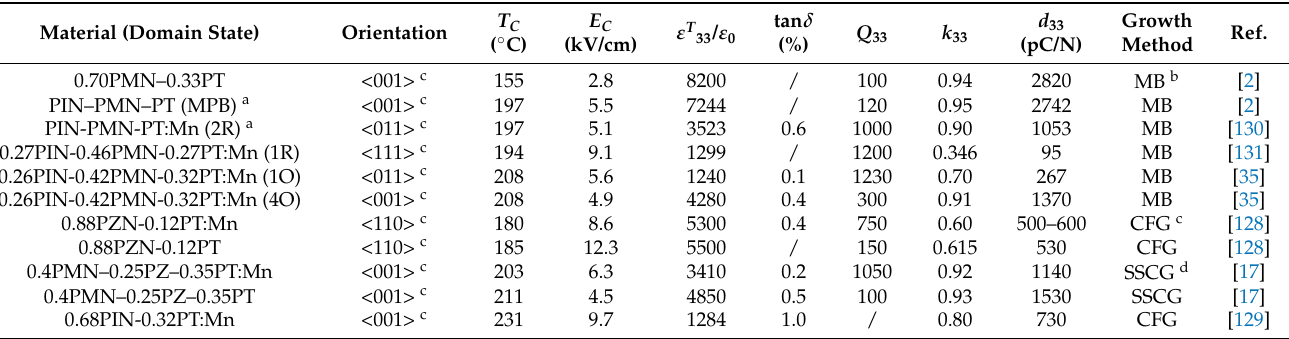
Table 4. Property comparisons of pure PMN-PT, pure and Mn-doped PIN-PMN-PT, pure and